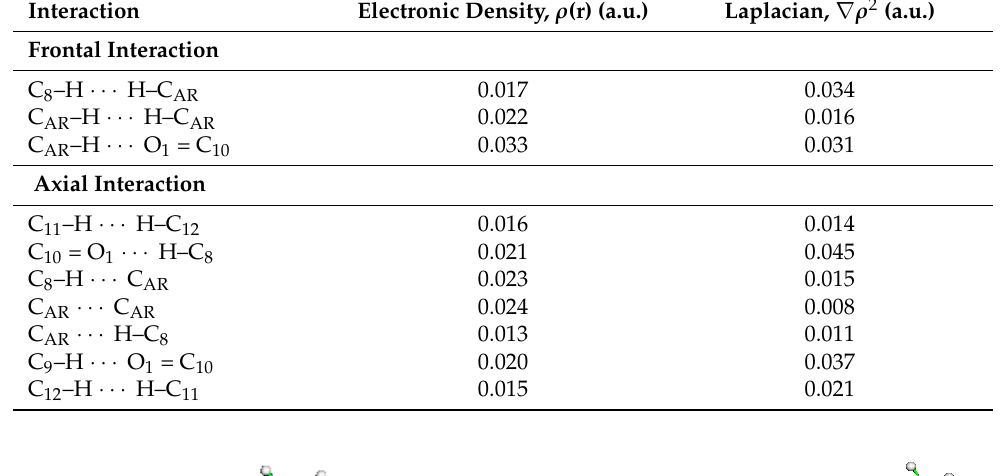
Table 6. Topological properties calculated on the molecular interactions in DEADP at the bond critical point.